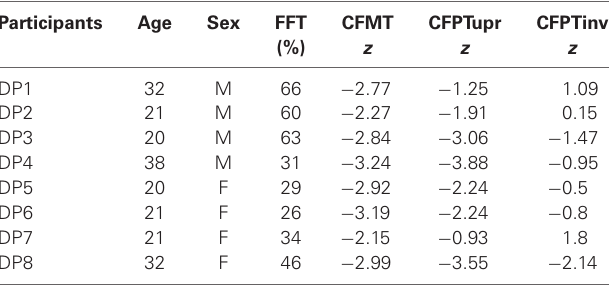
Table 1 | Neuropsychological testing results of the 8 DP cases: Famous Faces Test (FFT), Cambridge Face Memory Test (CFMT), Cambridge Face Perception Test upright and inverted (CFPTupr and